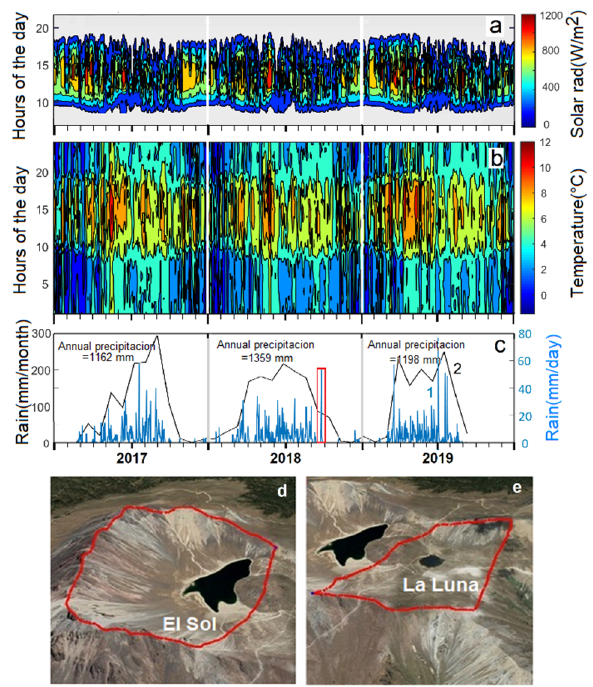
Figure 3. Hourly variability of solar radiation ( a ), air temperature ( b ) and precipitation ( c ) measured during 2017–2019 at the NMS station. In ( d , e ), the red curves show the runoff areas in the crater lakes of the Nevado de Toluca volcano.